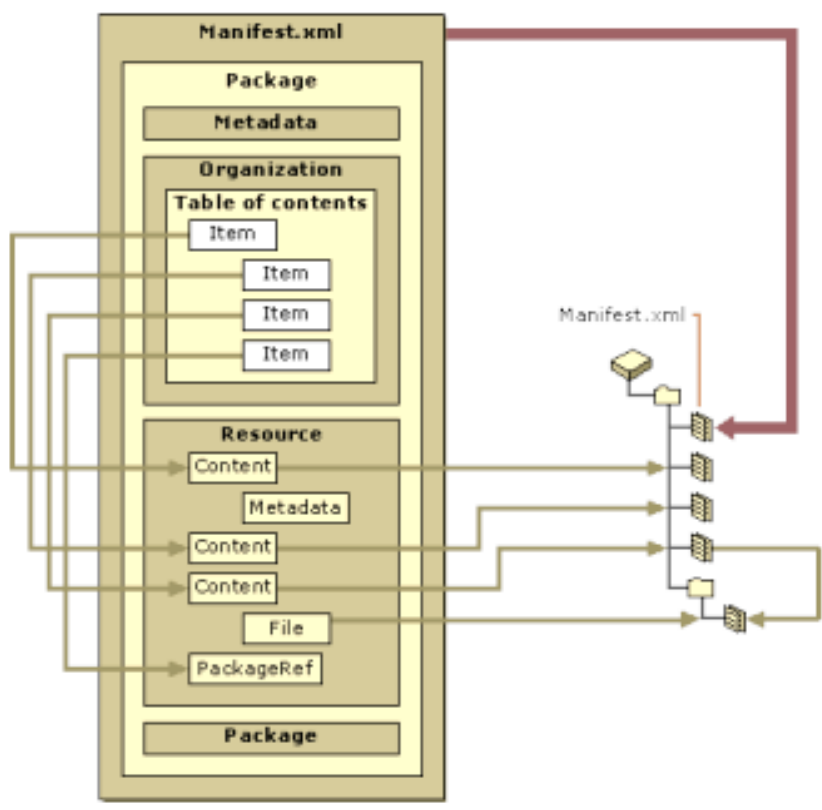
Figure 6: LMS Conceptual